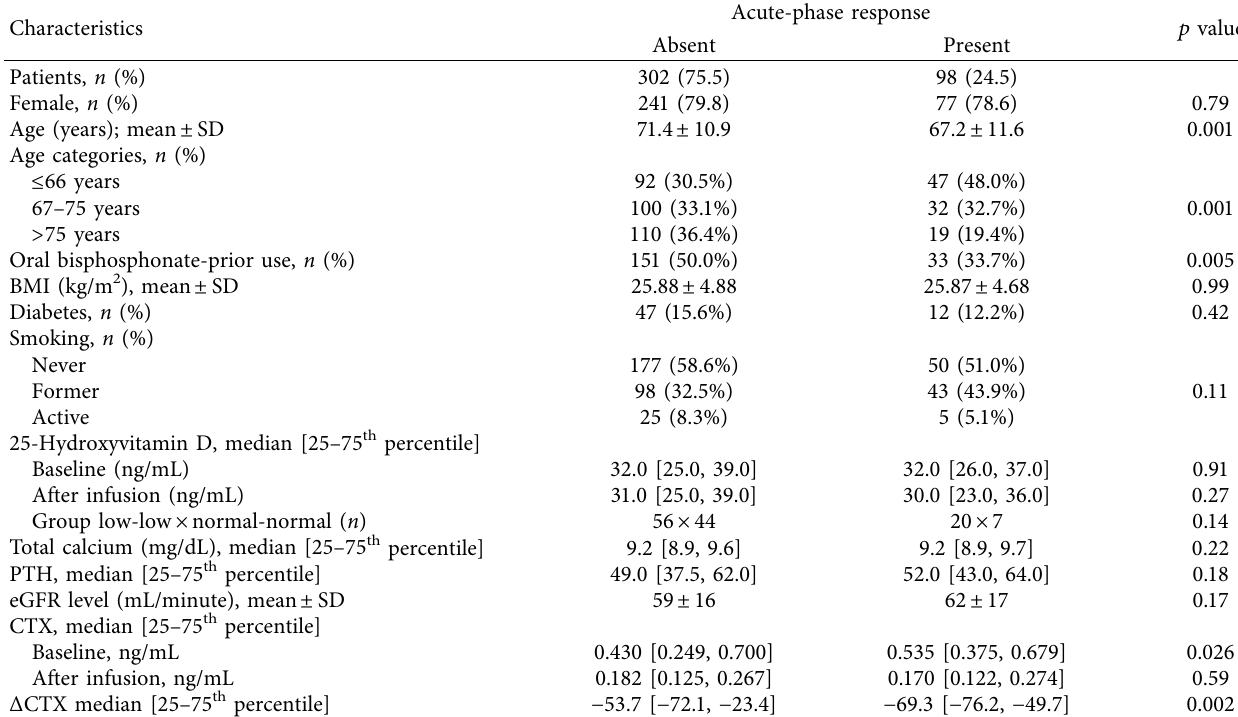
Table 2: Demographic and clinical characteristics of 400 patients according to the presence or absence of zoledronic acid infusion acute- phase